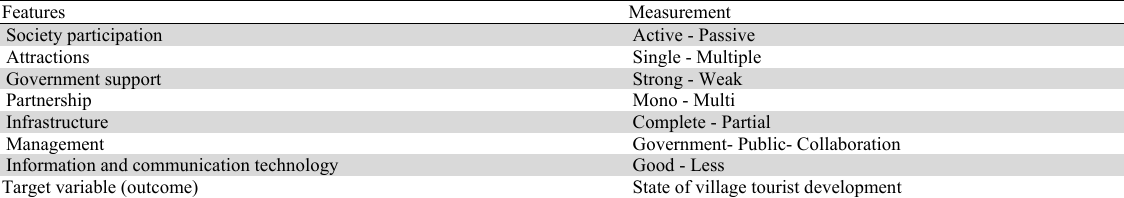
Features of Tourist Village and Measurement Scale